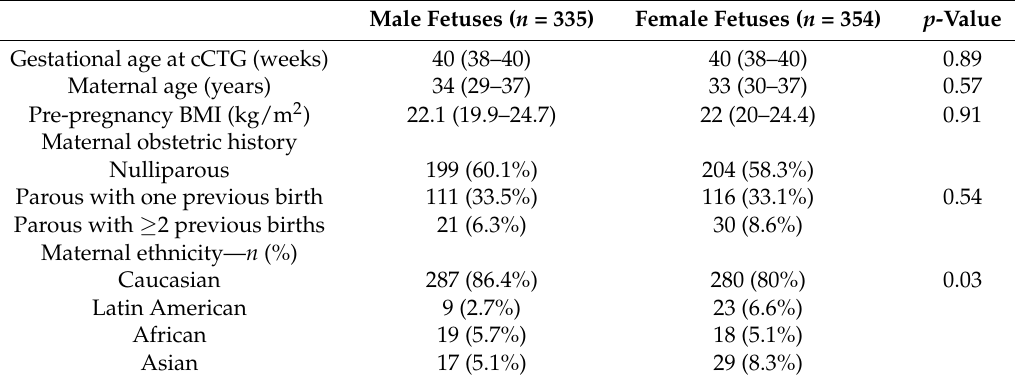
Table 1. Maternal characteristics according to fetal sex.